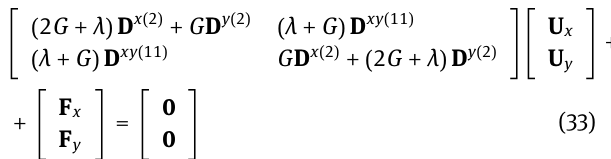
Figure 2: Corners and edges enumeration of the master